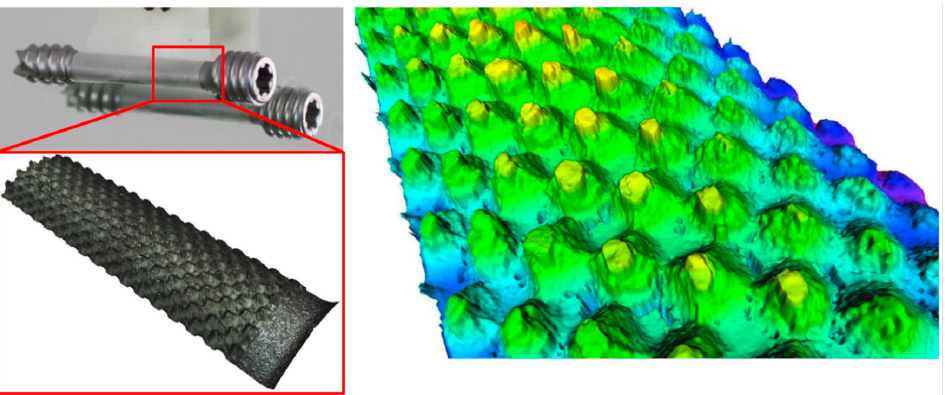
Figure 7 . Surface structure for overmolded polymer; overview of the structure ( left ) and detailed measurement of the structure ( right ).